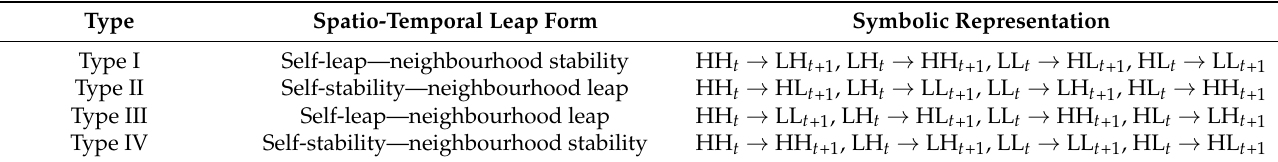
Table 1. Type of space–time transition.